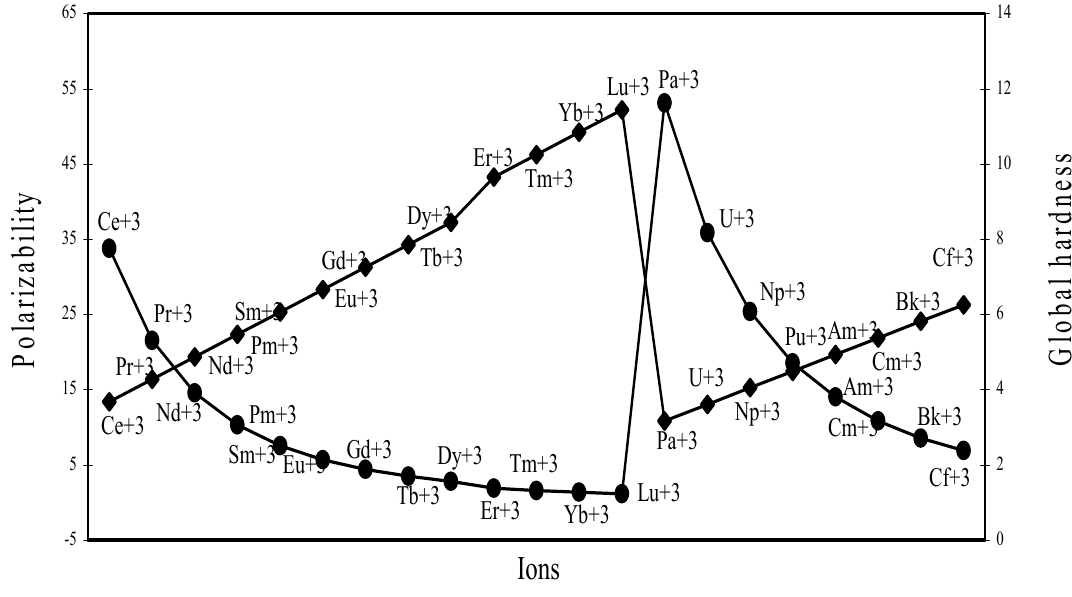
Figure 28. Plot of polarizability and global hardness of ions of elements of lanthanide and actinide series.